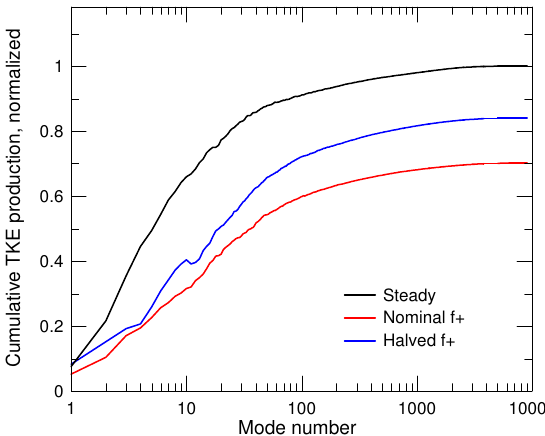
Figure 11. Cumulative contribution to the TKE production rate of each POD mode. The values are obtained by integration over the 2D measurement